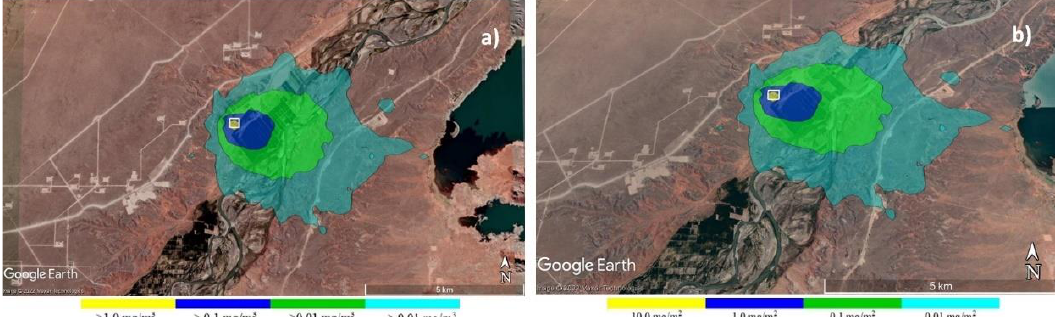
Figure 4. ( a ) Bioaerosol concentration downwind of the feedlot from HYSPLIT on the 5 April 2022 at 13:00 UTC considering an emission source between 0 and 1.5 m above the ground ( b ) deposition from HYSPLIT for the 5 April 2022 at 14:00 UTC.